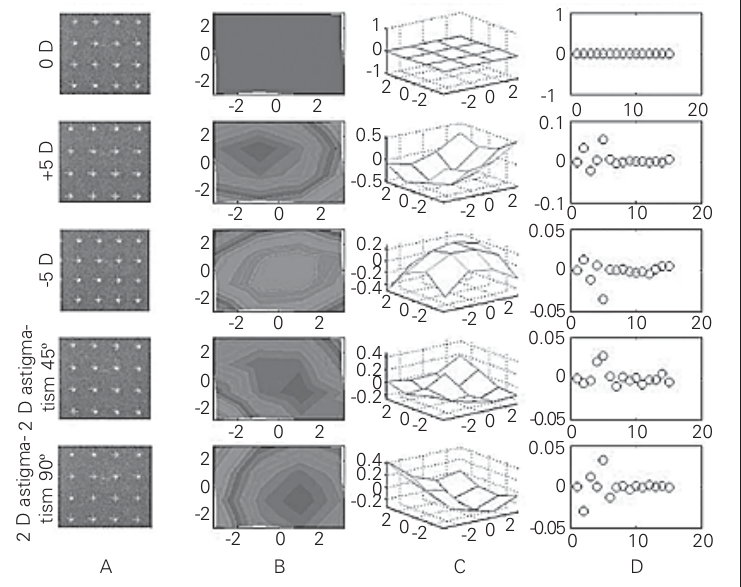
Figure 7. Results for all five measurements. A , Hartmann-Shack (HS) images for all five aberrations showing HS spots with superimposed “centers of mass” (gray crosses) detected by our image process- ing algorithm. B , Two-dimensional view of the wave- fronts calculated from the Zernike coefficients retrieved from the HS spots in A and from Equations 6-13. C , Same as in B , but plotted as three-dimensional (x, y, z) graphs. D , Zernike coefficient values for each aberra- tion. Notice that for the plane wave-front they are all zeros, as expected. These are the Zernike coefficients which are added to Equation 9 in order to retrieve the wave-fronts plotted in B and C .